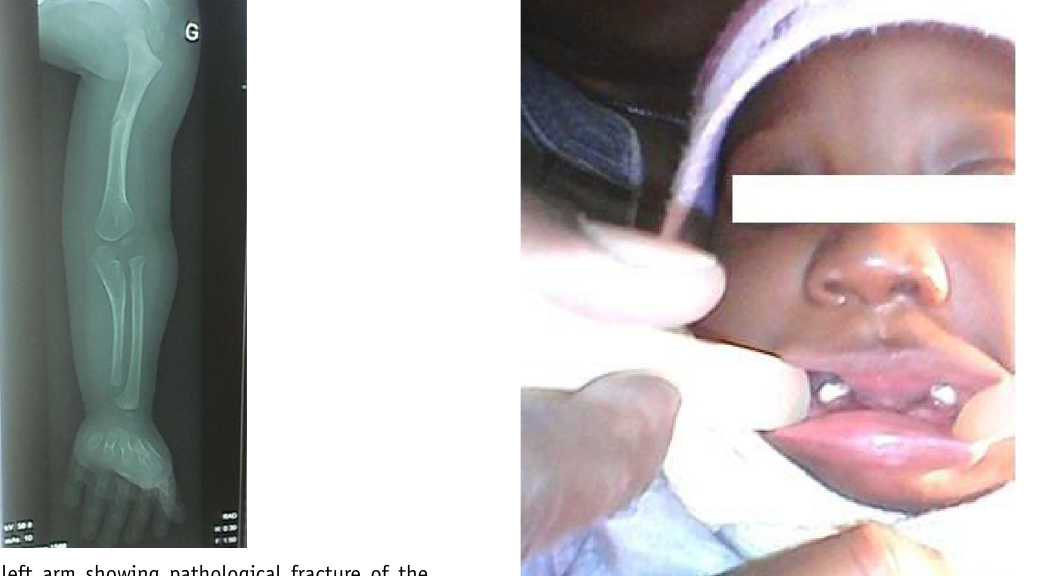
Fig. 6. X-ray of the left arm showing pathological fracture of the humerus.